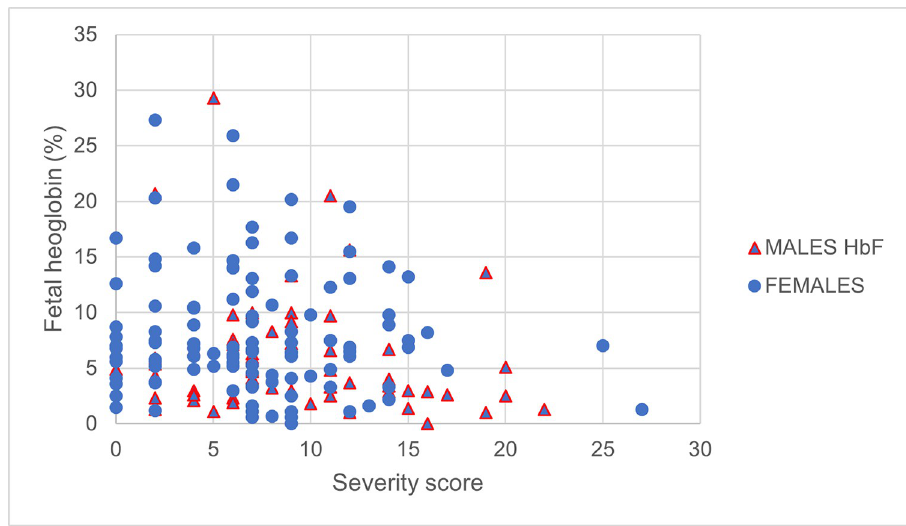
Fig 3. Fetal hemoglobin and severity score according to